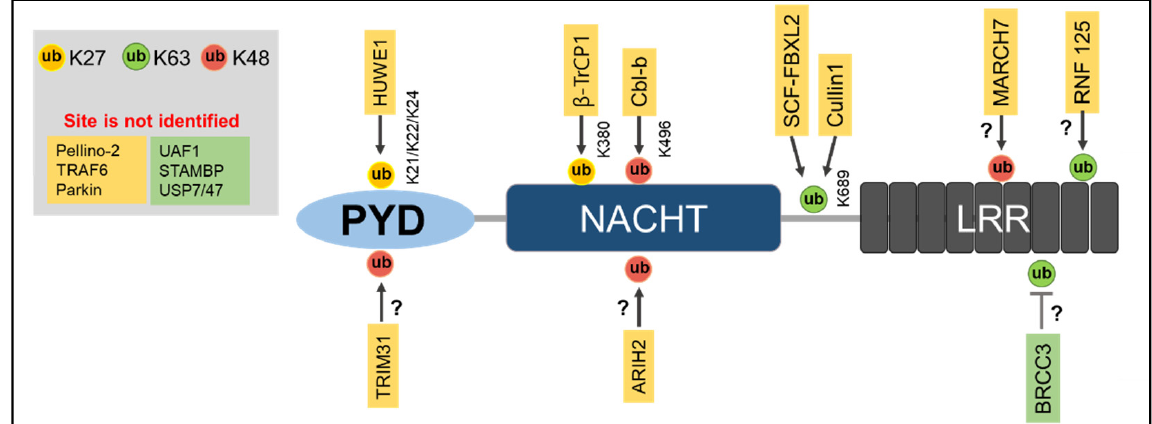
Figure 1. E3 ligases and DUBs involved in ubiquitination and deubiquitination of NLRP3. E3 ligases and DUBs targets different lysine sites of NLRP3 for ubiquitination or deubiquitination. Yellow indicates ubiquitin ligases and green indicates deubiquitinase (DUB).